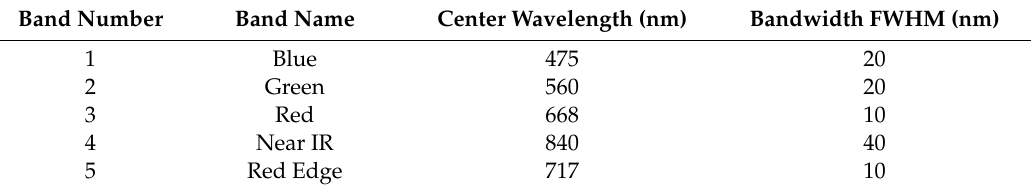
Table 2. Spectral bands of the MicaSense RedEdge multispectral camera.